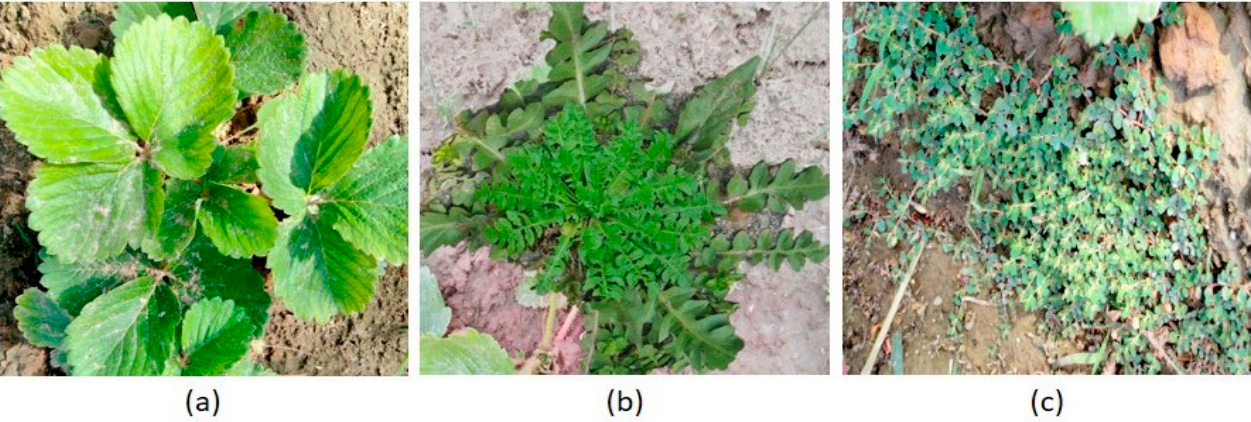
Figure 2. Sample of dataset images. ( a ) Strawberry plant ( b ) shepherd purse weed and ( c ) spotted spurge weed.